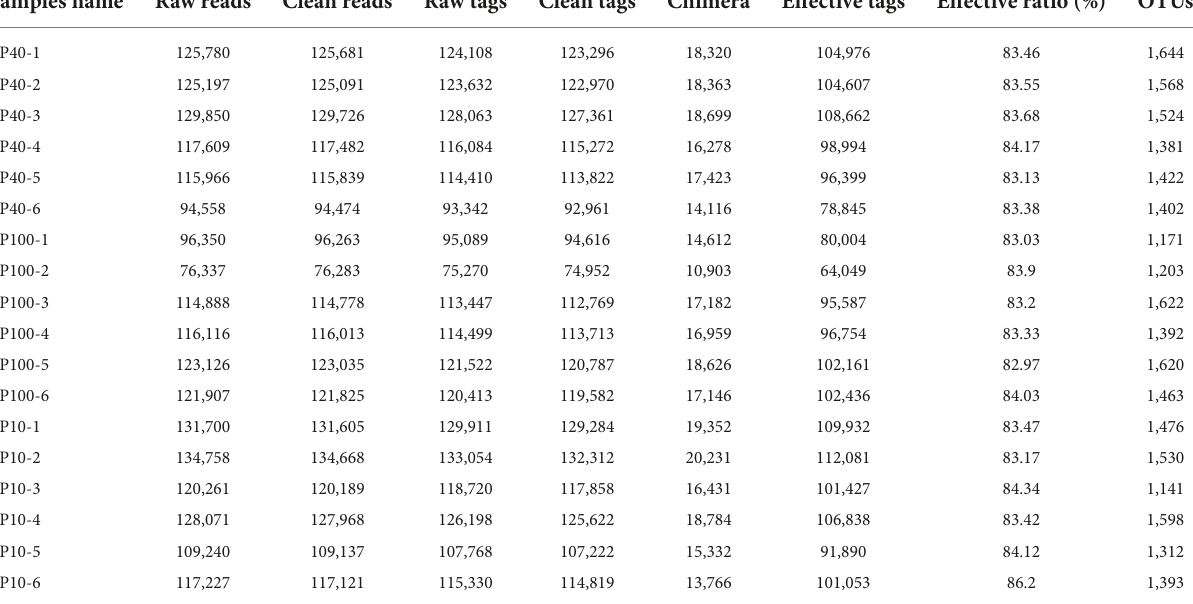
TABLE 1 Quantitative statistics of tags and